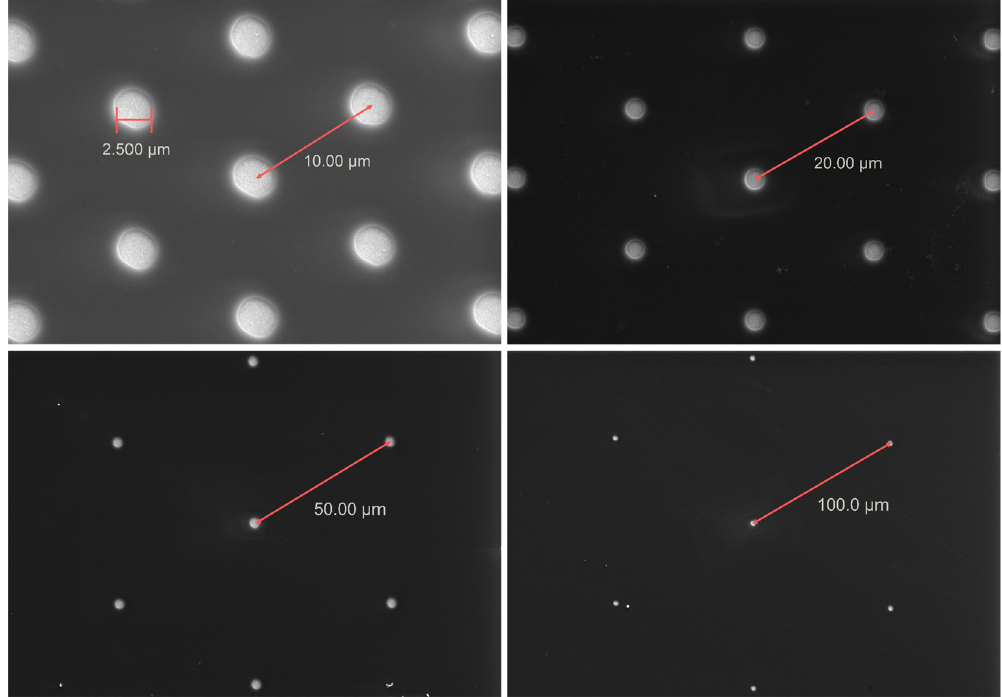
Figure 6. Electron micrographs of the microelectrode ensembles.